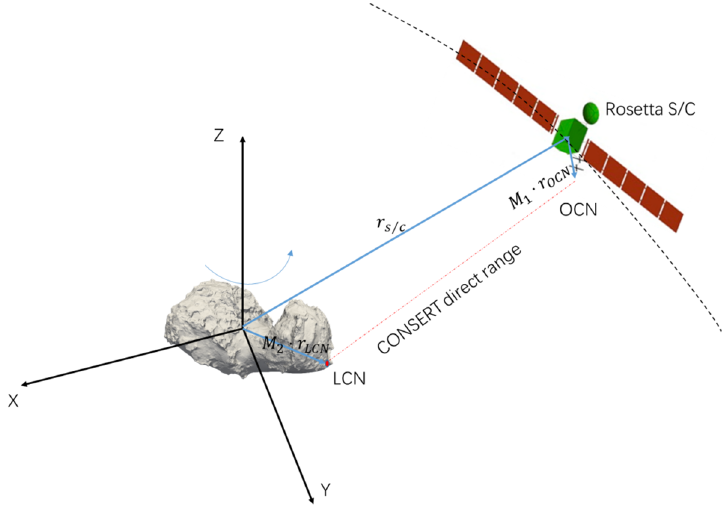
Figure 2. CONSERT direct range measurement model in the comet-centered J2000 frame.